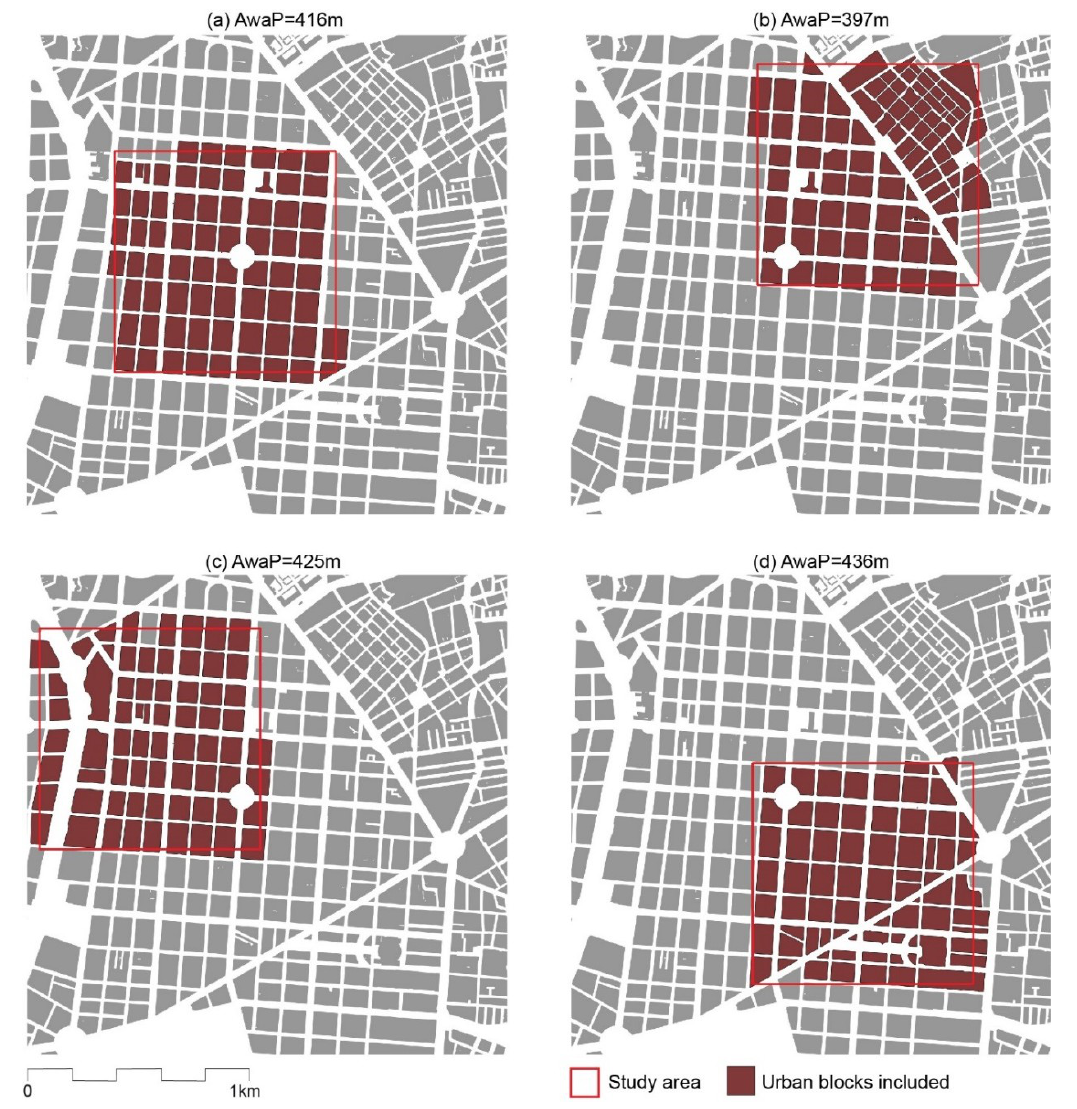
Figure 5. Measuring AwaP in Madrid.